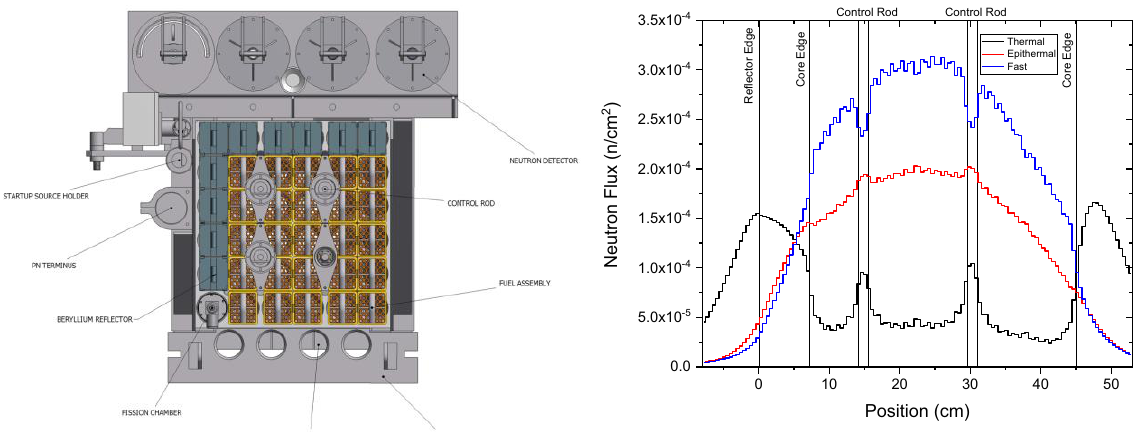
Fig. 1. A layout of the PULSTAR’s core including the fuel assemblies and the beryllium reflectors appearing on the top and left side of the core (left). The calculated energy and spatial distribution of neutrons in the PULSTAR core illustrating the large flux of thermal neutrons (energy less than 0.5 eV) in the core’s periphery (right).